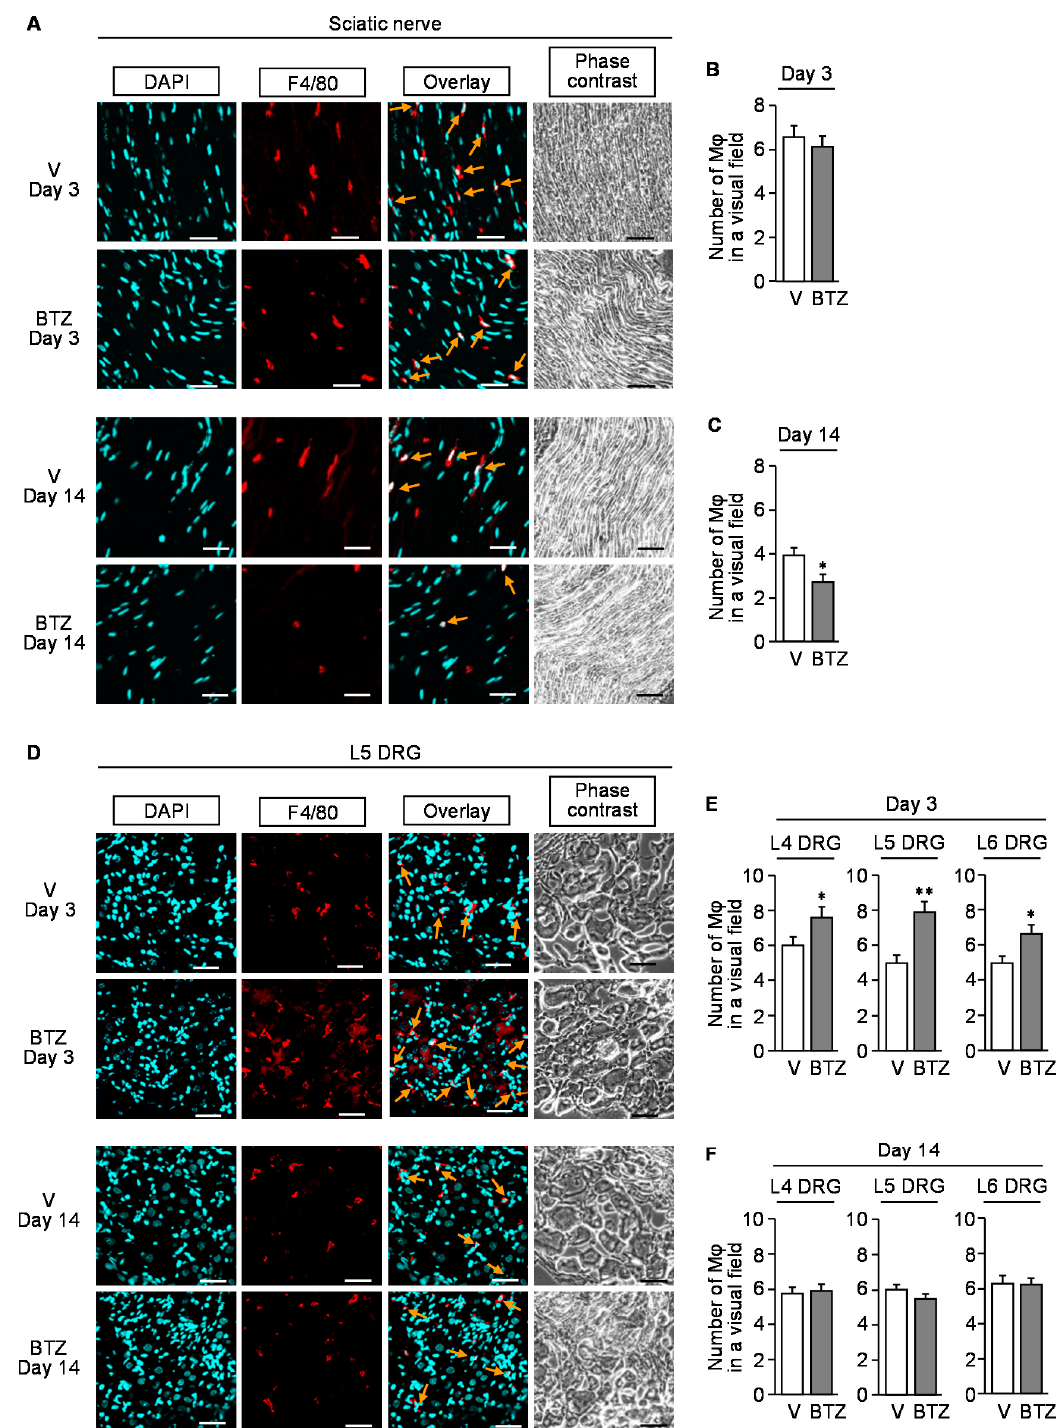
Figure 5. Immunofluorescence detection of macrophages in the sciatic nerve or dorsal root ganglion of the mice with CIPN caused by bortezomib. Bortezomib at 0.4 mg/kg or vehicle was administered i.p. on days 0, 2, 5, 7, 9, and 12. The sciatic nerves ( A – C ) and dorsal root ganglion ( D – F ) were isolated from the mice on day 3 or 14 after the onset of bortezomib treatment. ( A , D ) Typical microphotographs for the immunofluorescence staining of F4/80-positive macrophages (arrows) in the sciatic nerve ( A ) and L5 dorsal root ganglion ( D ). Blue, DAPI (nucleus); red, F4/80 (macrophage); scale bar, 50 µm. ( B , C , E , F ) The number of F4/80-positive cells in a visual field of the sciatic nerve ( B , C ) and L4–L6 dorsal root ganglion ( E , F ) excised on day 3 ( B , E ) and day 14 ( C , F ). M φ , macrophage; V, vehicle; DRG, dorsal root ganglion; BTZ, bortezomib. Data show the mean with S.E.M for 20 visual fields from 5 mice. * p < 0.05, ** p < 0.01 vs. V.